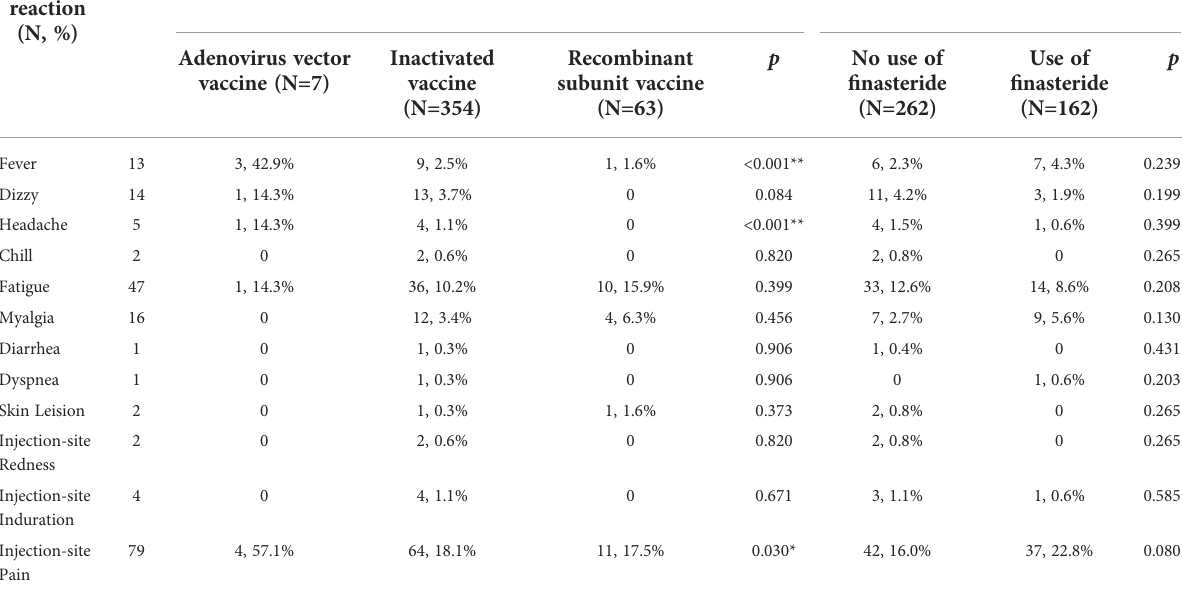
TABLE 3 Adverse reactions of vaccination by the vaccine types and the treatment among AGA patients (N=424). Adverse